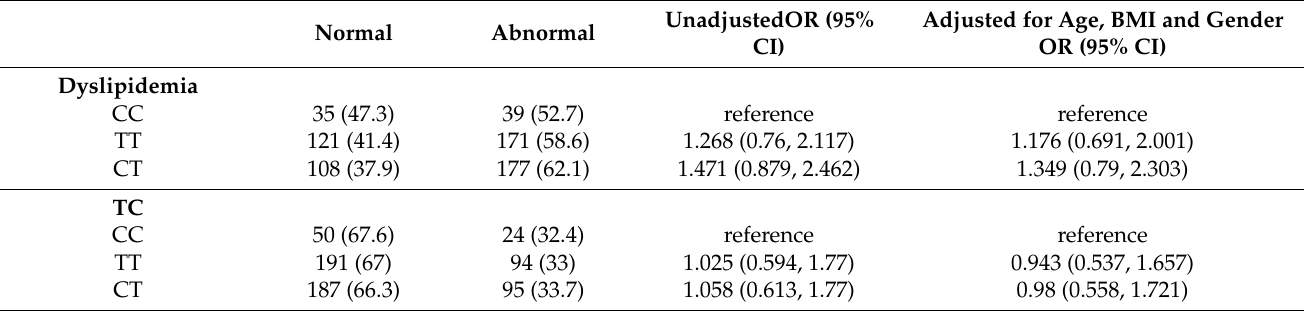
Table 5. Logistic regression analysis of dyslipidemic abnormalities and the three genotypes of the ABCA1 C69T